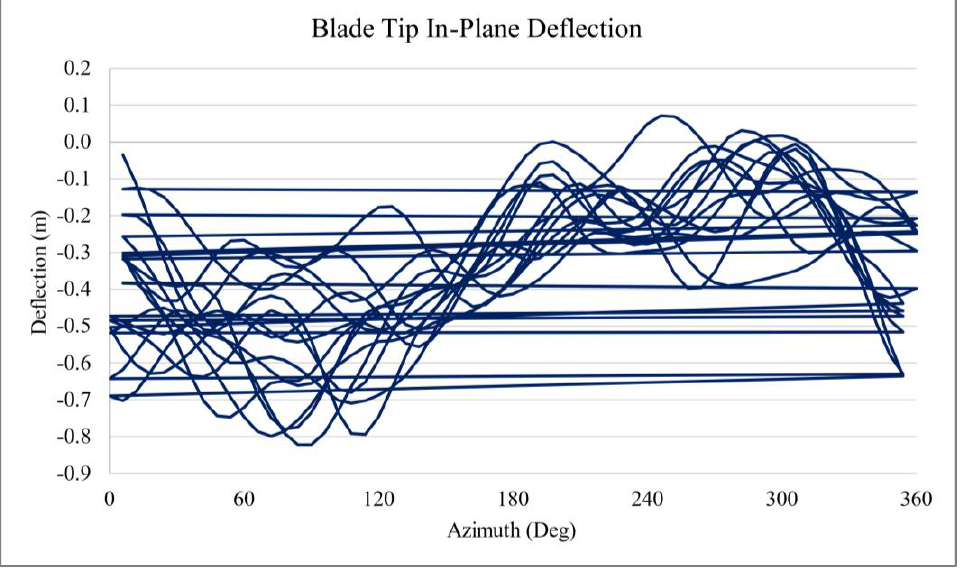
Figure 15. Blade Tip In-Plane Deflection with Azimuth Angle - 50% Turbulence